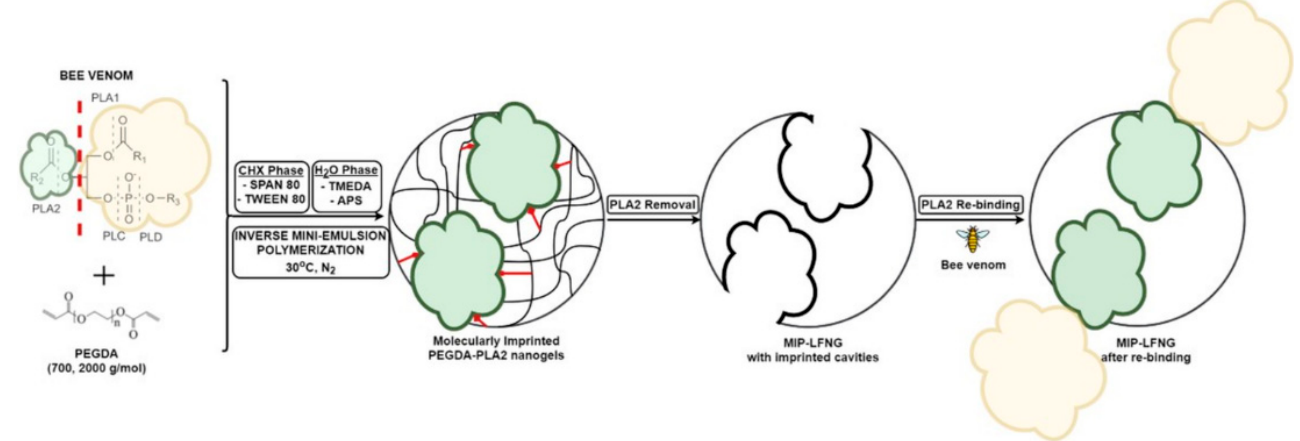
Figure 1. Fourier transform infrared (FT-IR) spectra of NIP-LFNG; PLA2 enzyme (PLA2); and MIP-LFNG (W or T) and MIP-LFNG (W, ext or T, ext) before and after PLA2 extraction, respectively.